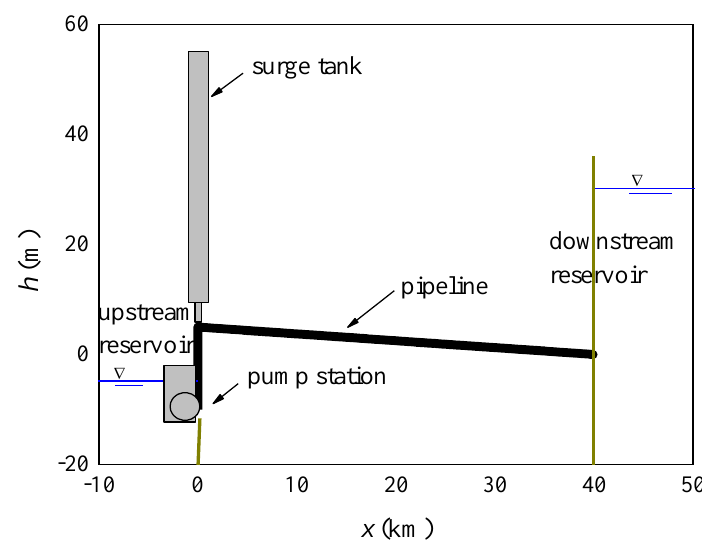
Figure 1. Schematic of the pipeline and surge tank.